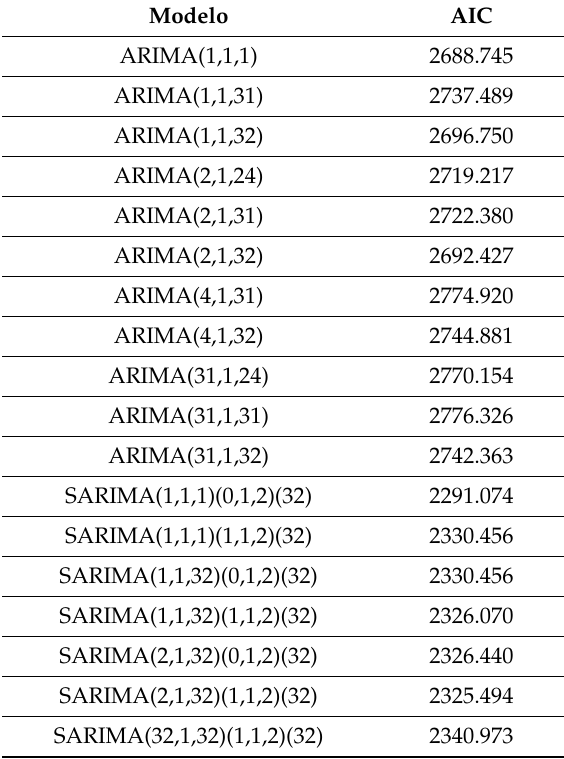
Table 3. AIC (Akaike information criteria) coe ffi cient for various